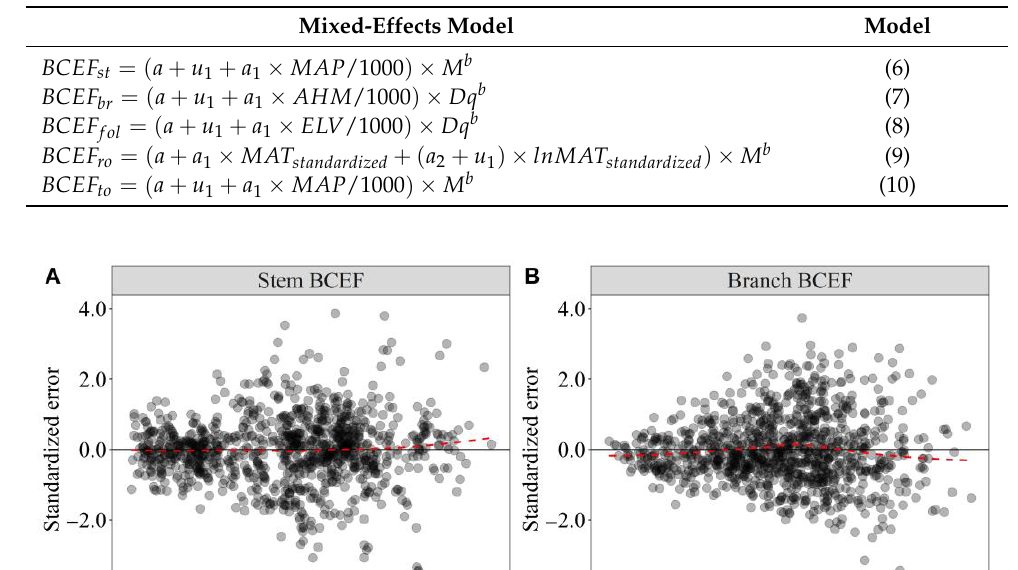
Table 7. Mixed-effects model of biomass conversion and expansion factor of each component.